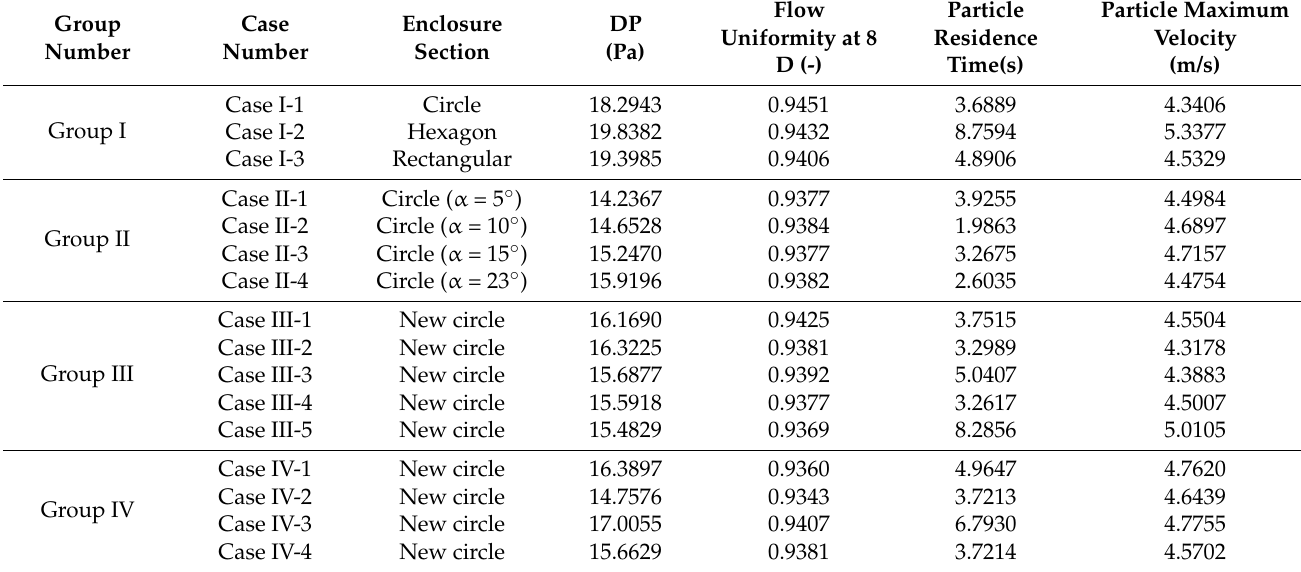
Table 2. Summary results of the enclosure design for brake wear particles measurement.